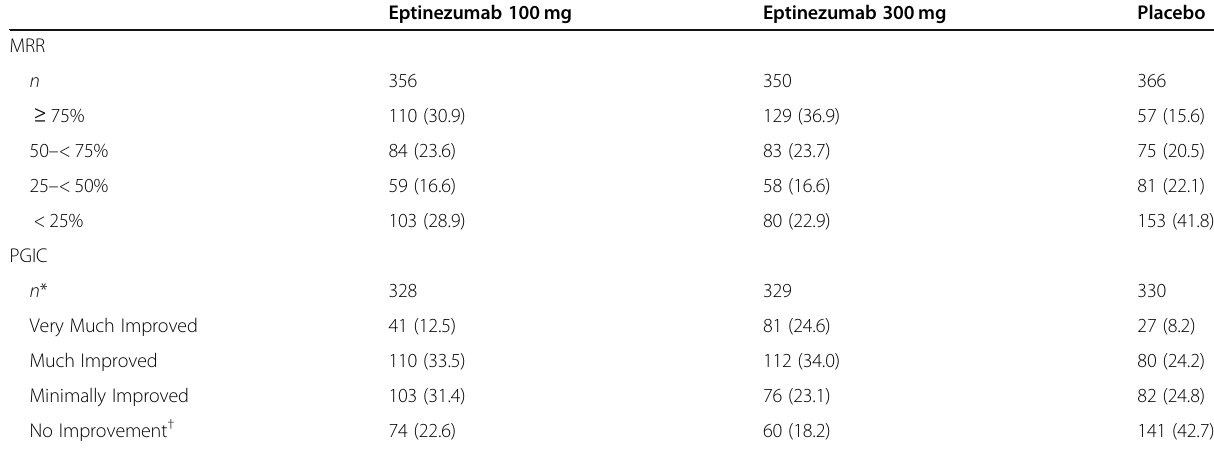
Table 1 MRR and PGIC at Month